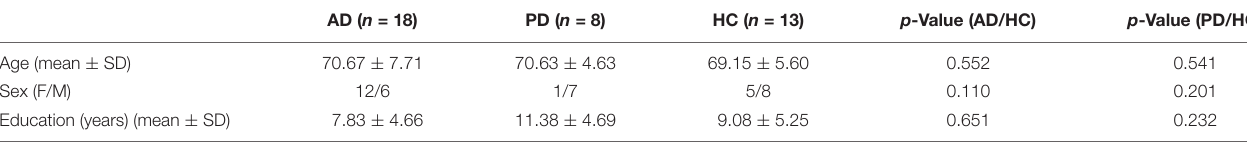
TABLE 1 | Demographic data were given of AD, PD, and healthy control (HC) groups.